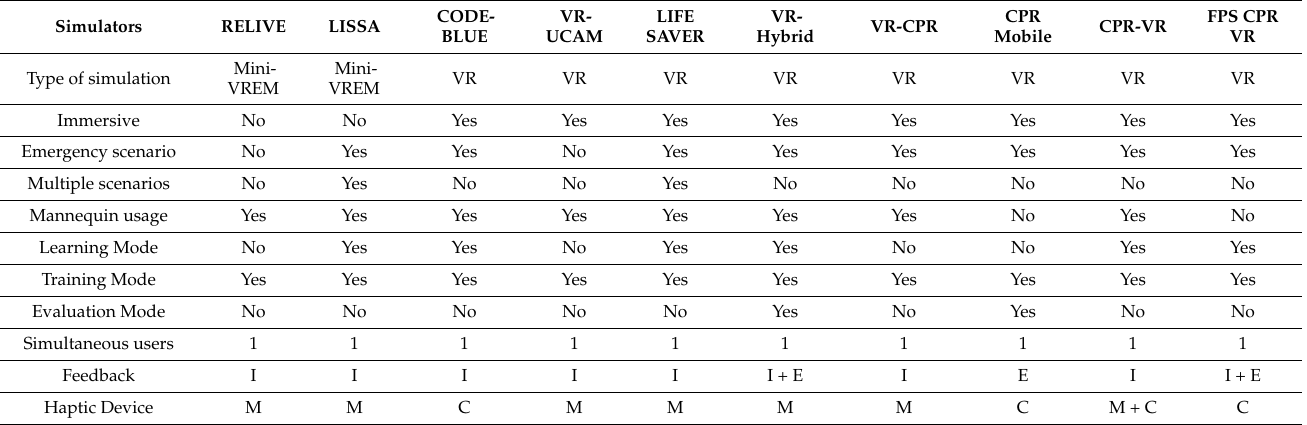
Table 2. Simulators and their collected